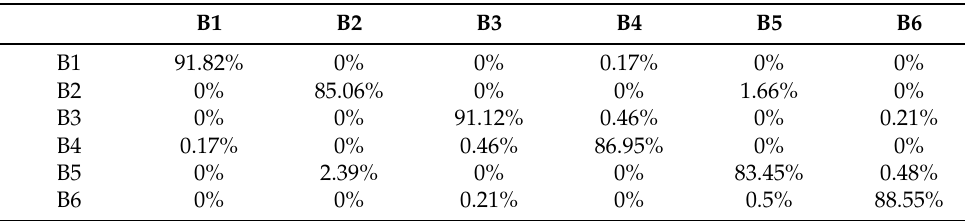
Table 1. Compatibility ratio for the Xilinx Spartan 6 x 4 + x + 1.